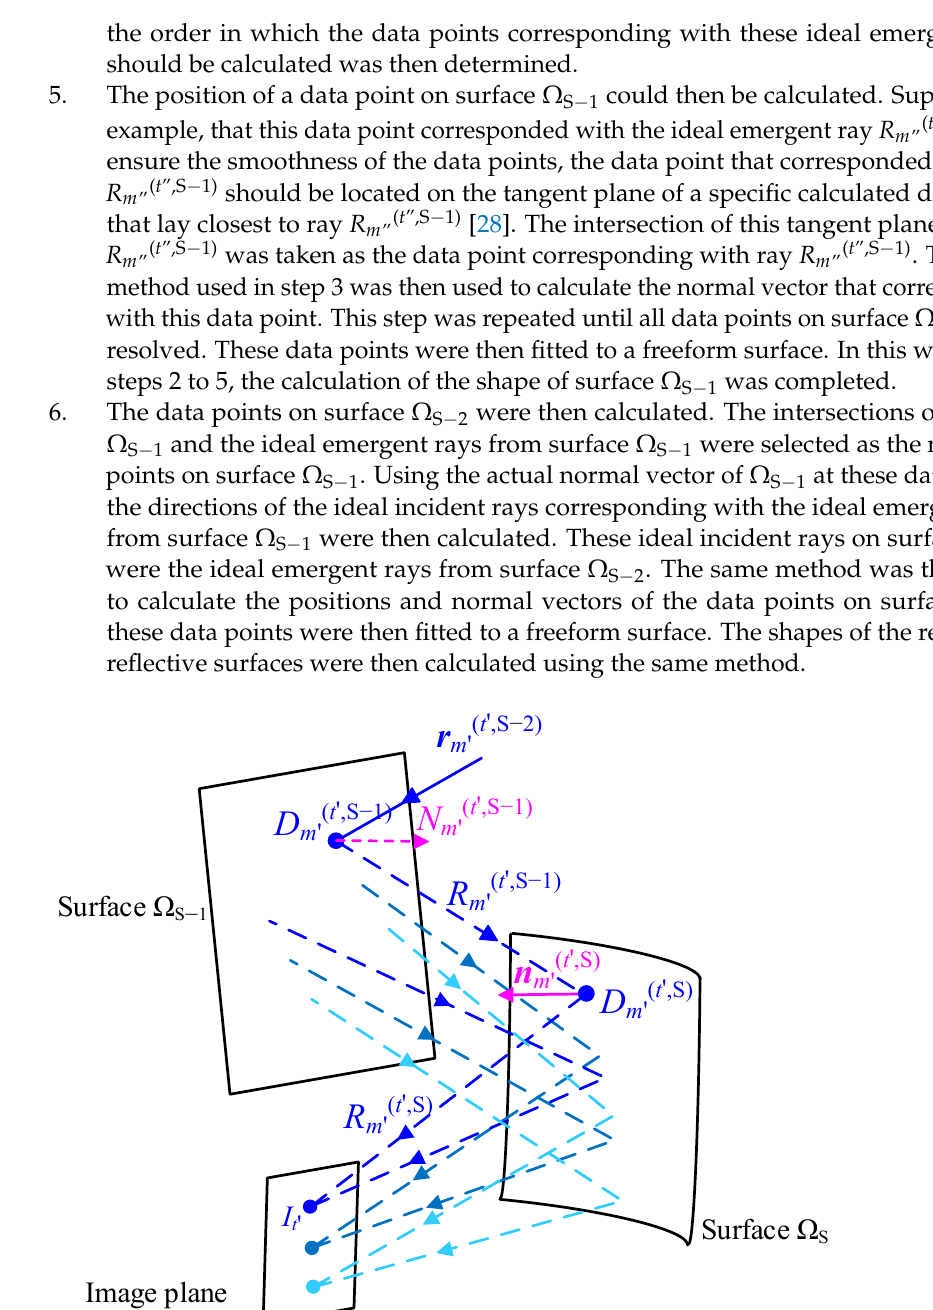
Surface Ω S Image plane Figure 1. Calculation of data points during the construction process. Figure 1. Calculation of data points during the construction process. After all the surfaces of the system were constructed as freeform surfaces, the iteration process was used to improve the imaging quality of the system. The calculation method for the data points used in the iteration process is now introduced with the p -th reflective surface Ω p of the system being taken as an example here. Using the same method that was used in the construction process, the ideal emergent ray R m ( t , p ) from surface Ω p was calculated. As shown in Figure 2, the position of the intersection of ray R m ( t , p ) and surface Ω ( t , p ) on surface Ω p was selected as the position of data point D m p . The actual direction of incidence r m ( t , p − 1) of a ray from the t -th feature field at point D m ( t , p ) was obtained by ray tracing. The ideal normal vector N m ( t , p ) of surface Ω p at point D m ( t , p ) was then calculated using the law of reflection. After all the data point calculations were completed, the